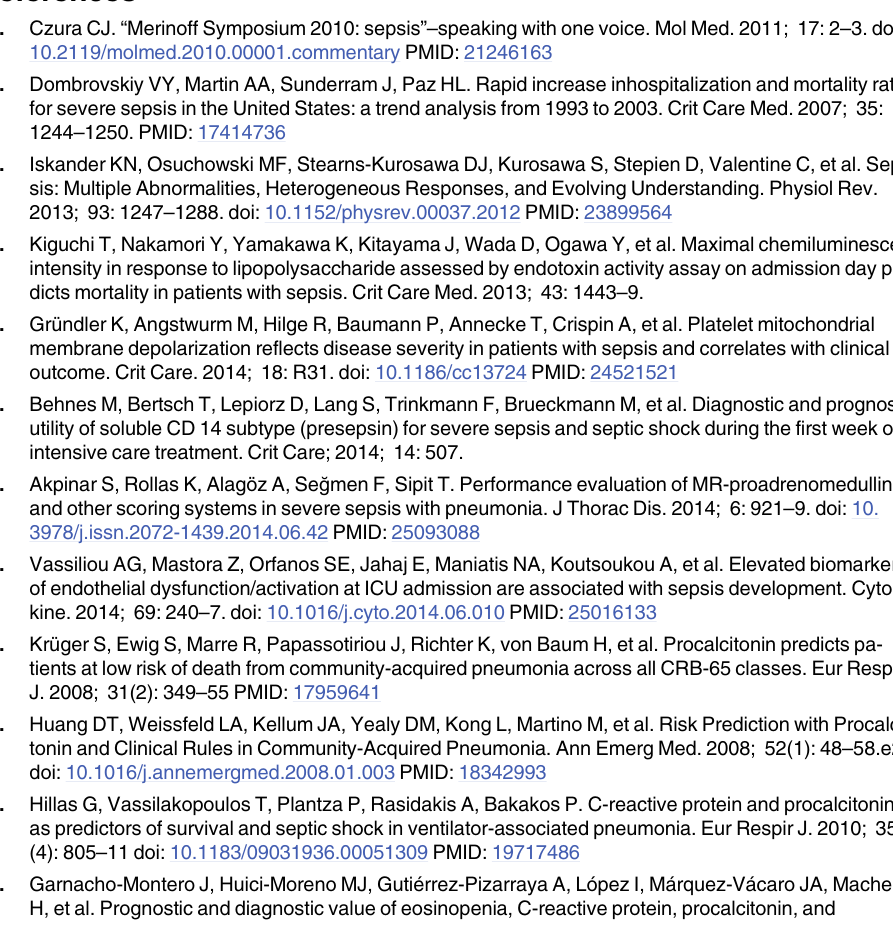
S1 Fig. Forest plot of the sensitivity and specificity of procalcitonin concentration for pre- dicting mortality in sepsis. S2 Fig. Forrest plot of the sensitivity and specificity of procalcitonin non-clearance for pre- dicting mortality in